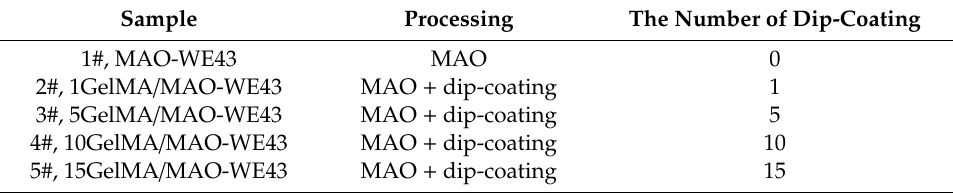
Table 1. The processing of samples.